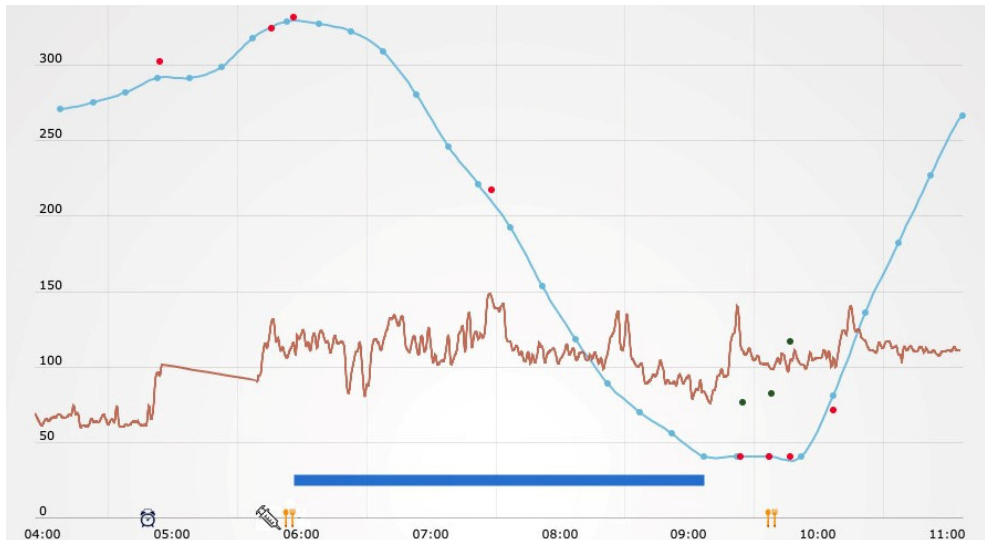
Figure 12. BG and HR profiles related to a selected pattern occurrence. On the timeline, the blue line represents the time interval in which the selected pattern (in this case, decreasing BG value) occurred.